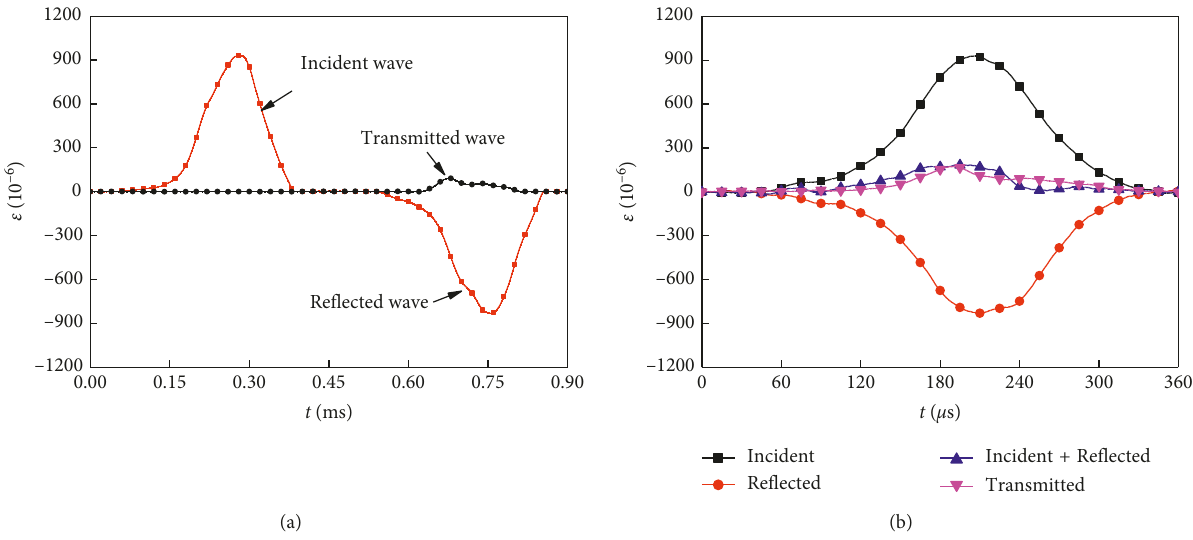
Figure 3: Dynamic tensile tests on sandstone specimens: (a) waveforms; (b) validation of the uniform stress assumption.